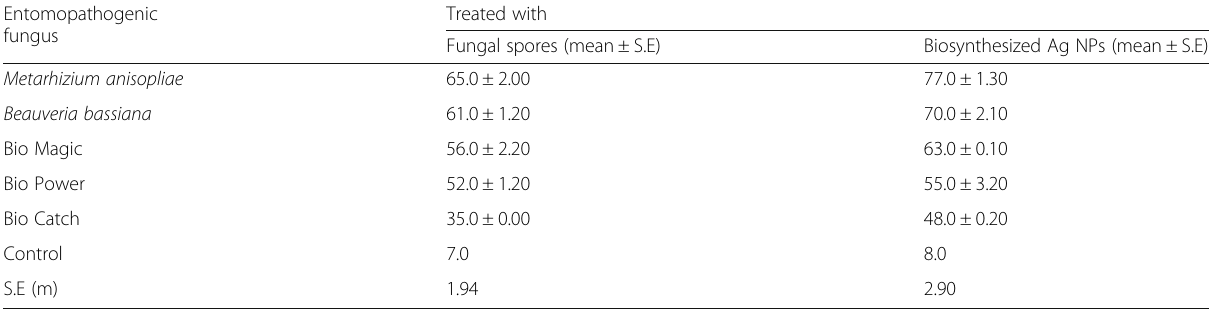
Table 3 Mortality percent of entomopathogenic fungi on the adults of Rhynchophorus ferrugineus using spore suspension and biosynthesized silver nano-particles Entomopathogenic